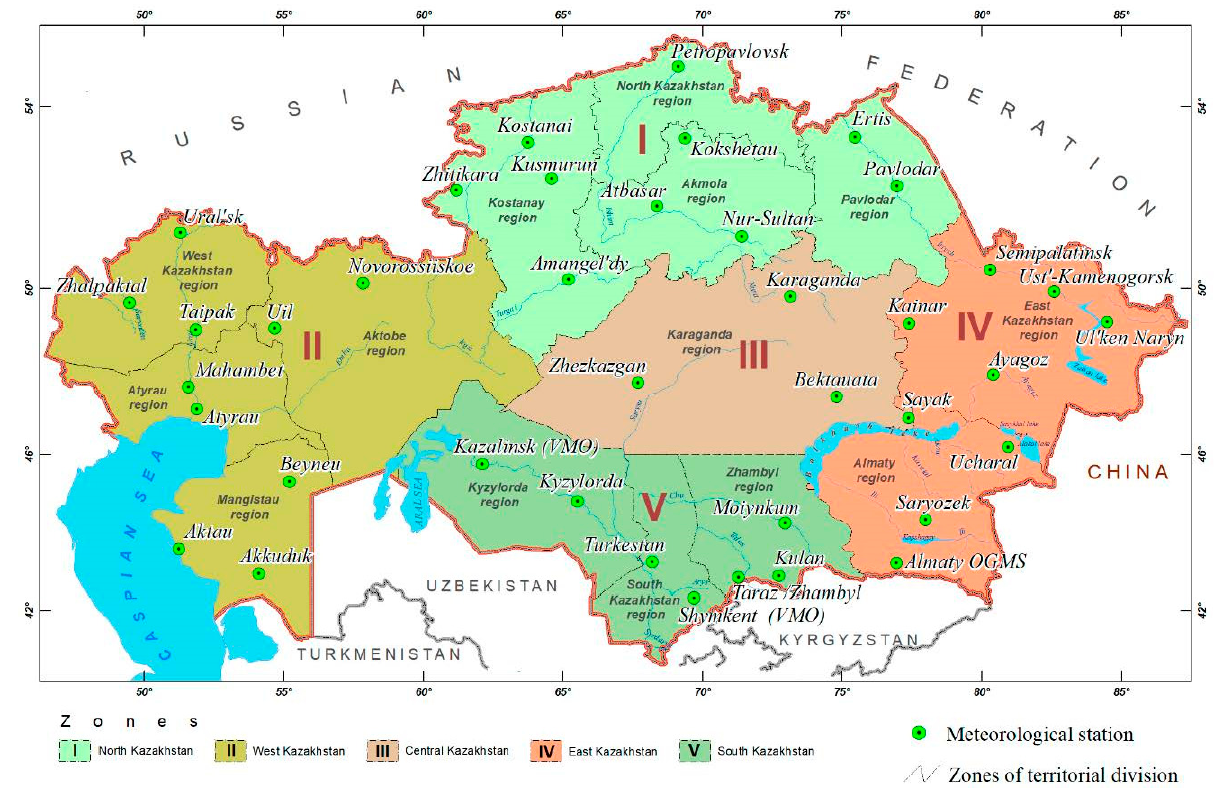
Figure 1. The administrative division and the distribution of 42 meteorological stations in Kazakhstan.